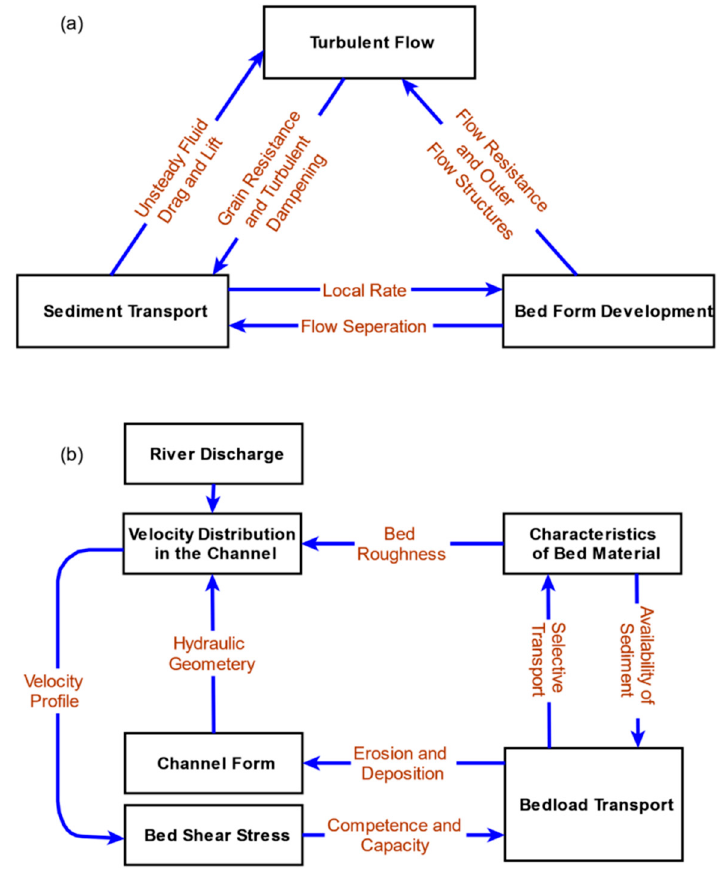
Figure 3. The conceptual relationship between flow, sediment, and morphology at a confluence, as proposed by ( a ) Leeder [11] and ( b ) Ashworth and Ferguson [12] .